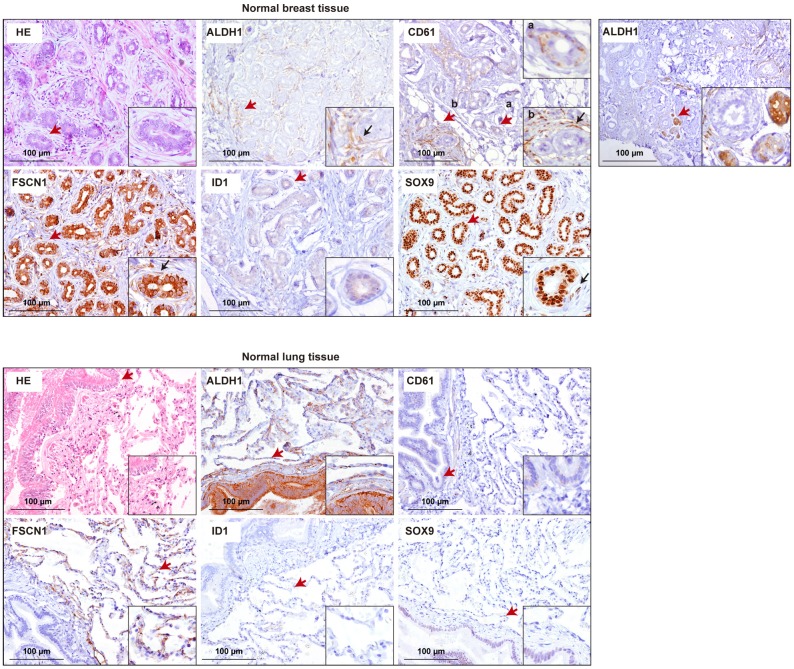
Immunohistochemical characterization of biomarkers in normal breast and lung tissue.(A) Representative hematoxylin-eosin and immunohistochemical staining in normal breast tissue. The observed patterns of positivity were those expected with the exception of ALDH1, which could have showed positivity in the basal and luminal cell layers of the acini; nonetheless, this can only be observed at the growing end and branching of the ducts [48], which may be represented by the image shown in the right panel. Expression of ALDH1, CD61, FSCN1 and SOX9 was also seen in spindle-like cells surrounding the terminal extra-lobular ducts as well as in similar cells of the loose specialized intra-lobular stroma (arrows in insets). The results of CD61 are detailed for the basal cell layer in differentiated acini (a) and for spindle-like intra-lobular cells (b). The arrows mark magnified fields. (B) Representative hematoxylin-eosin and immunohistochemical staining in normal lung tissue. ALDH1 and FSCN1 mark the alveolar endothelium, and ALDH1 also marks the basal and luminal layers of the bronchioles. CD61, ID1 and SOX9 are not expressed in differentiated alveoli, and CD61 and SOX9 show positivity in the luminal and/or basal layers of the bronchioles.